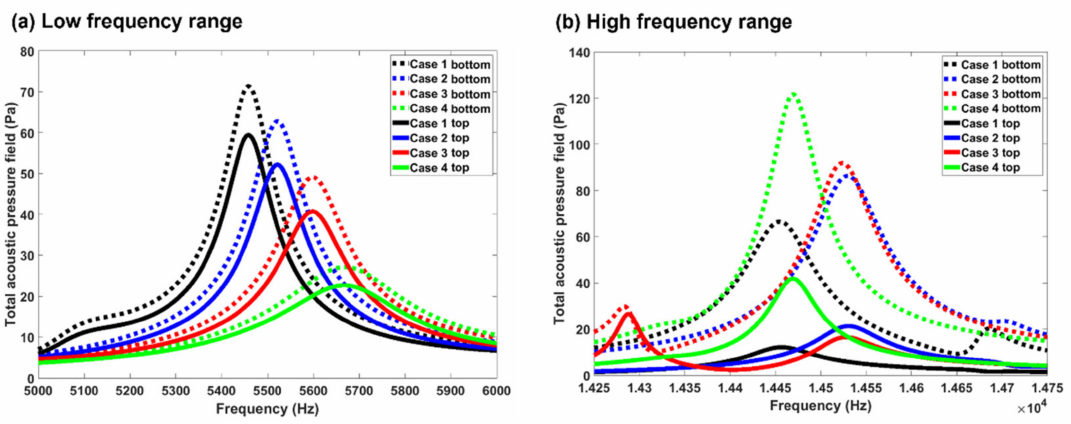
Figure 7. Comparison of acoustic pressure at some point at the top of olfactory volume and bottom of that region within the frequency range of ( a ) 5–6 kHz, and ( b ) 14,250 to 14,750 Hz.